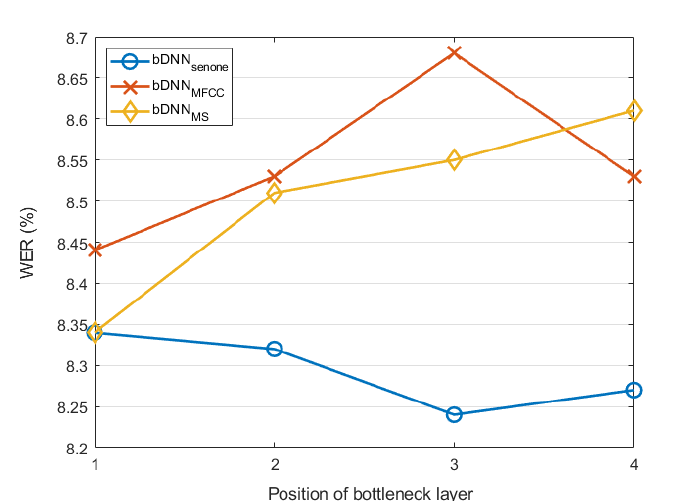
Figure 6. WER as a function of the position of the bottleneck layer on the “clean” test set (The result is the average for two types of the